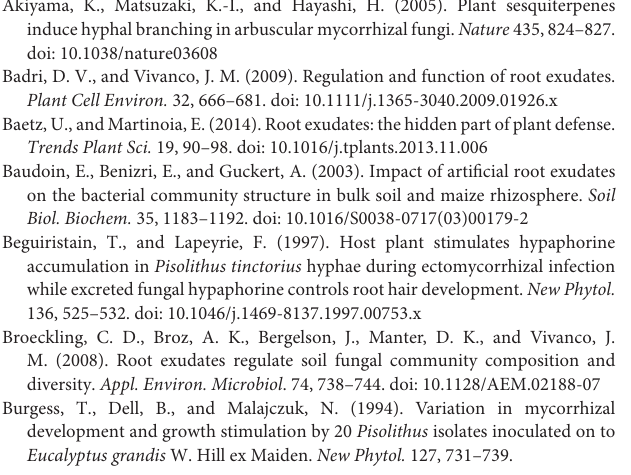
Supplementary Table 4 | Full list of differentially expressed genes in E. grandis. Fold change (FC) of the differentially expressed genes and their details, including